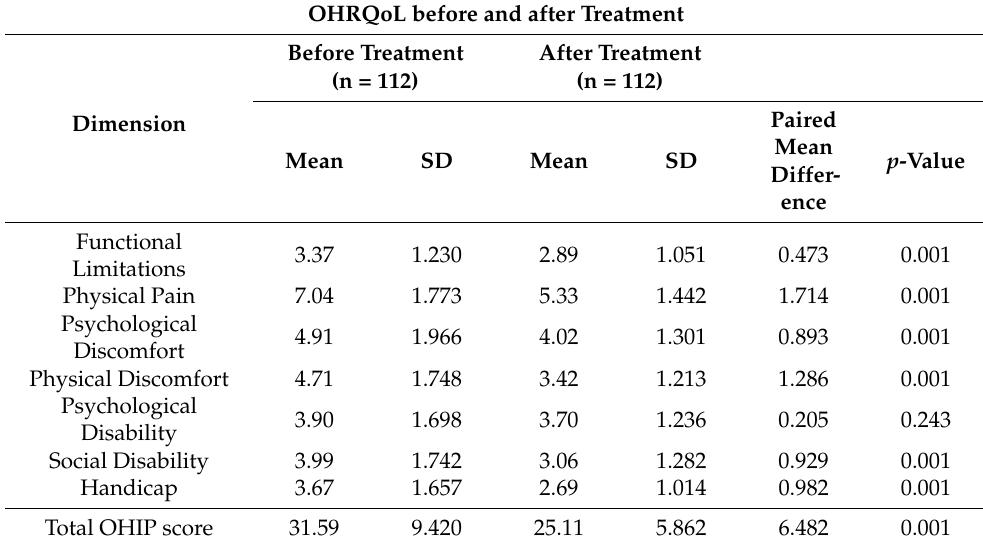
OHRQoL before and after Treatment Before Treatment (n = 112) Mean SD Mean SD